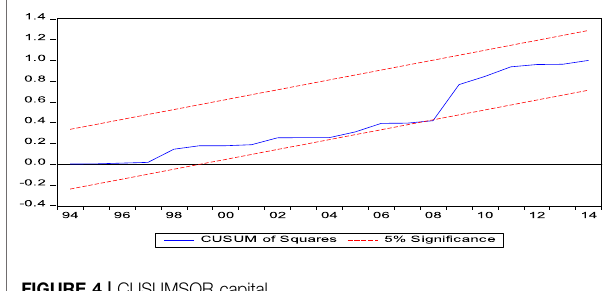
FIGURE 4 | CUSUMSQR capital.